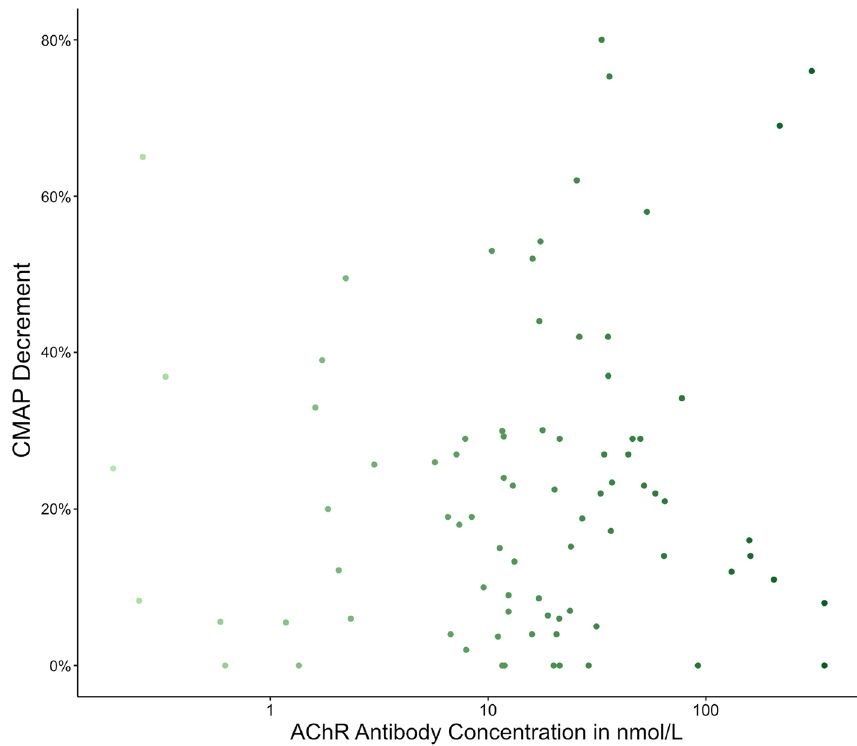
Figure 2. RNS-Antibody-Correlation: There is no clear correlation of CMAP decrement at RNS testing with the concentration of AChR antibodies in patients with AChR-Ab positive MG disease. The x-axis is represented on a logarithmic scale for better visualization.